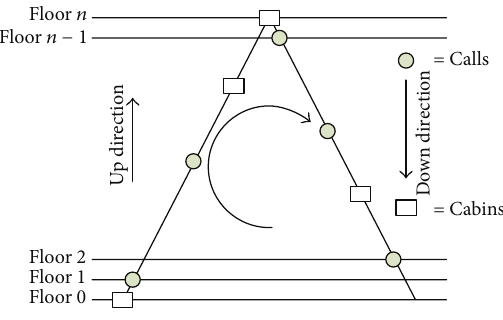
Figure 3: Proposed estimation